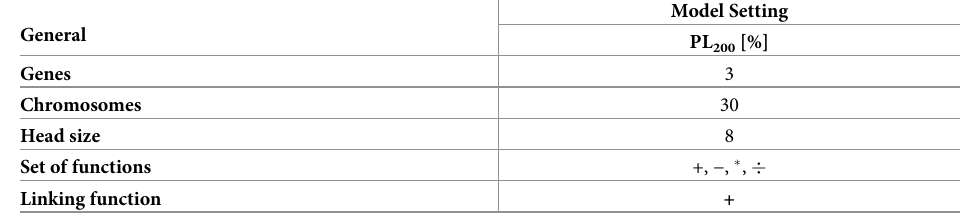
Table 2. General setting for prediction models.